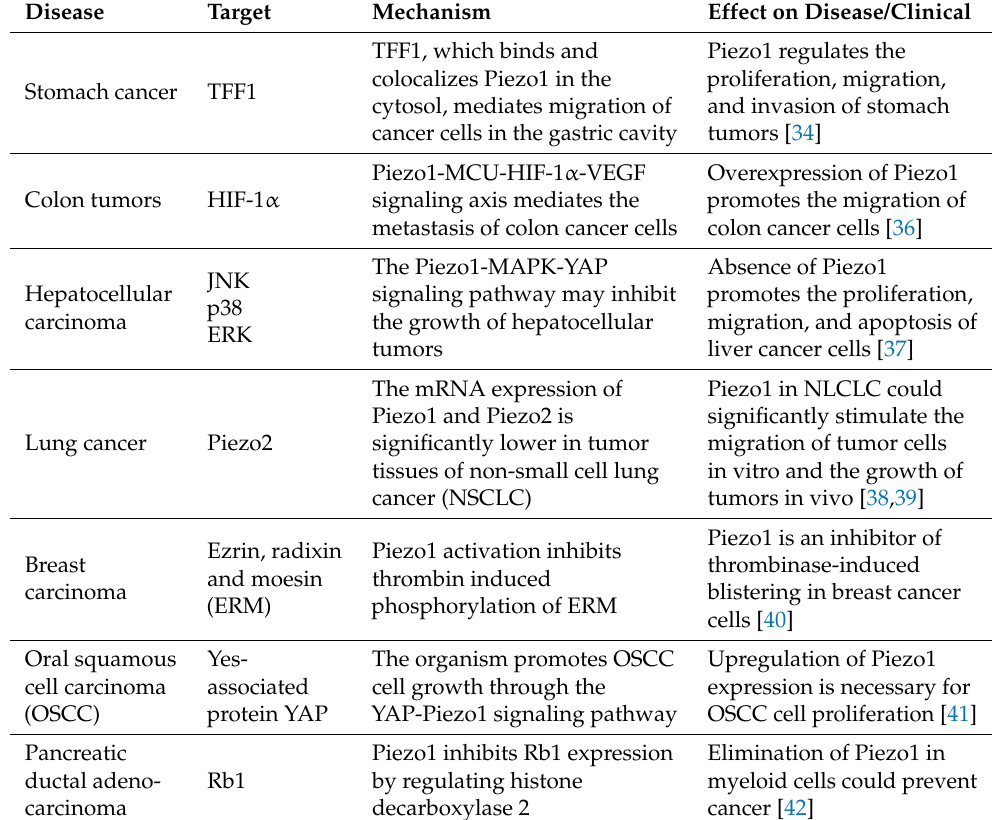
Table 2. Functional modulation of Piezo1 in